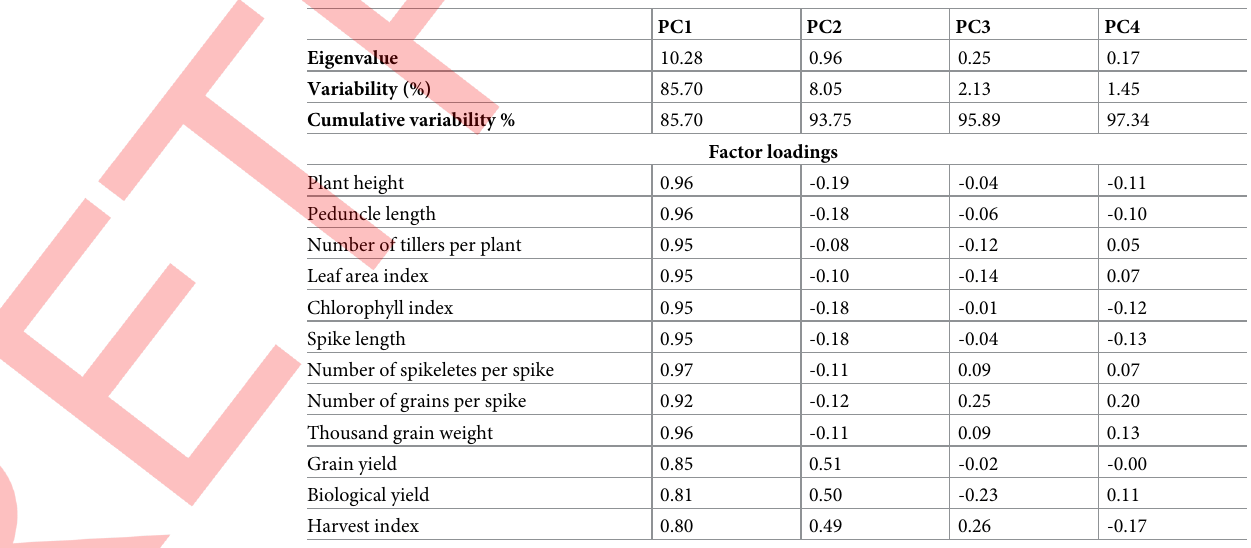
Table 5. Eigenvalues, variability explained and factor loadings of first four principal components obtained as a result of principal component analysis executed on growth and yield related traits of fort different wheat geno- types included in the